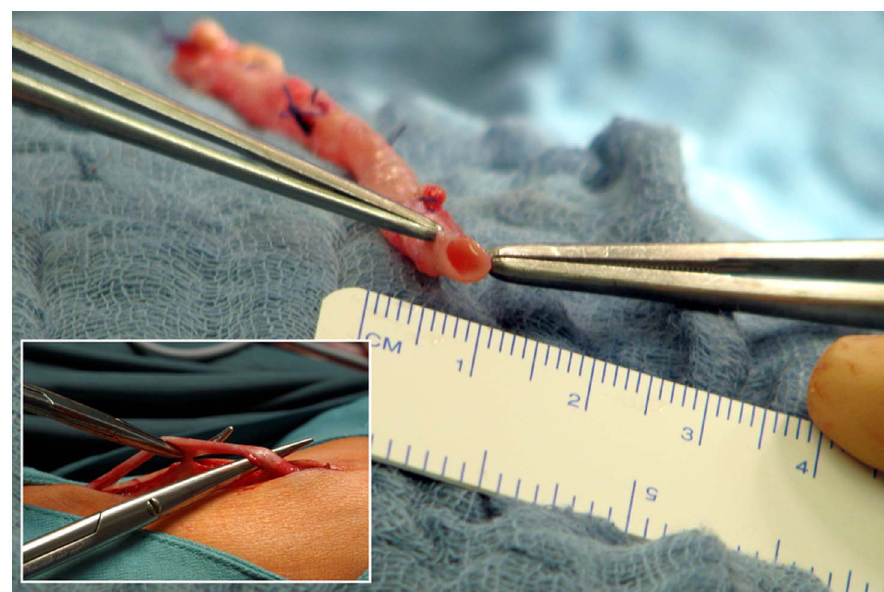
Figure 6. Intraoperative measurement of the dissected great saphenous vein.